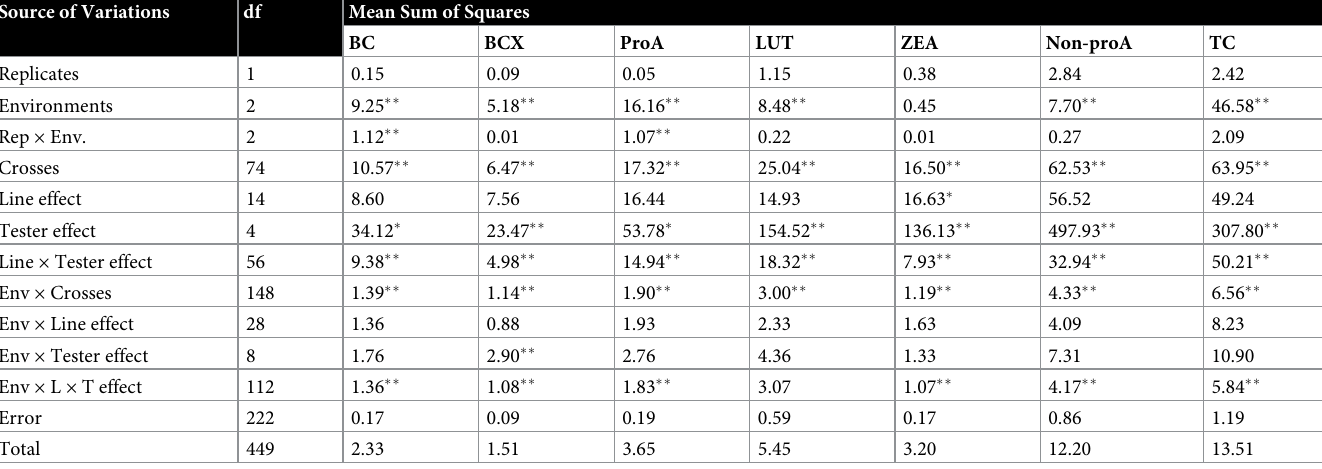
Combining ability estimates. The proportion of additive and dominance variance, and the contribution of lines, testers and line × testers for pooled dataset are presented in Table 7. Variance due to specific combining ability (SCA) was higher than variance due to general combining ability (GCA) for all the characters. Though, dominance variance was predominant for BC, BCX, proA and TC, additive variance was found to be important as well. Additive vari- ance was more for ZEA and non-proA, while both additive and dominance variance was of similar magnitude for LUT. When the contribution of lines, testers and line × tester were com- pared, line × tester interaction was found to be contributing more than line and testers for all the characters [36.55% (ZEA) to 67.15% (BC)]. General combiners for proA. GCA effect for proA varied from -1.52 to 1.27. Nine lines and one tester showed significant positive GCA effects for proA (S5 Table). Among the lines, MGU-PVMAS-10 (1.02) was the best general combiner, followed by MGU-PVMAS-5 (0.64),